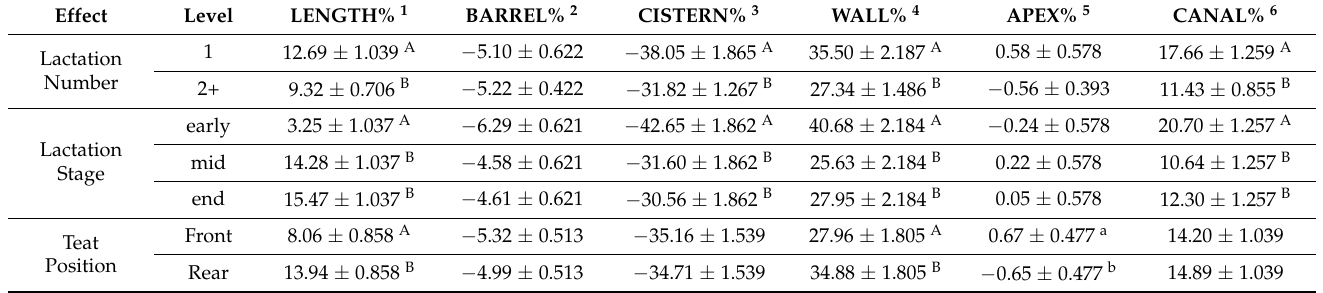
Table 1. The effect of lactation number, lactation stage, and teat position on the least-square means ± SEM of milking-induced changes in teat